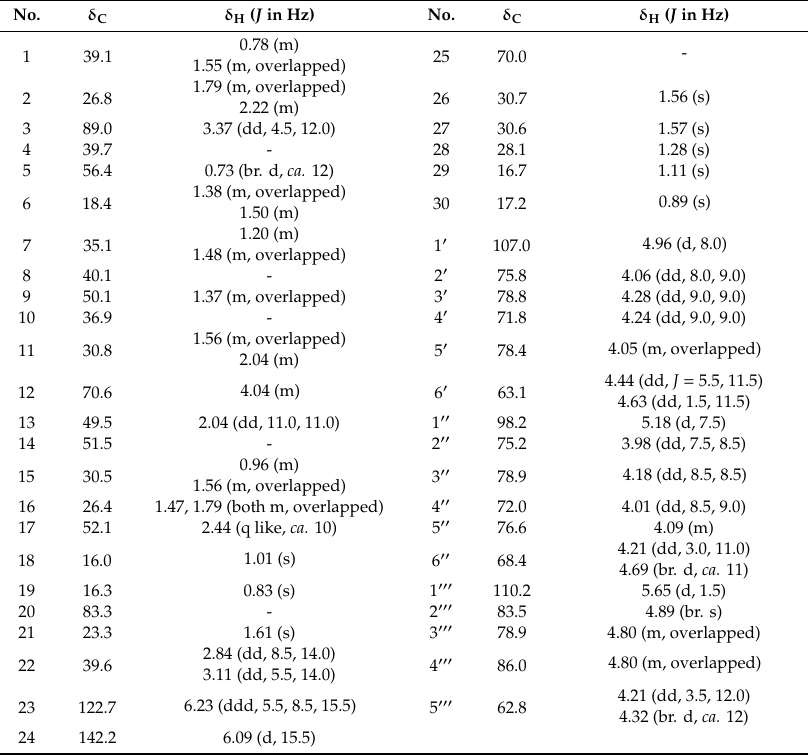
Table 5. The 1 H and 13 C-NMR data for 5 in C 5 D 5 N.